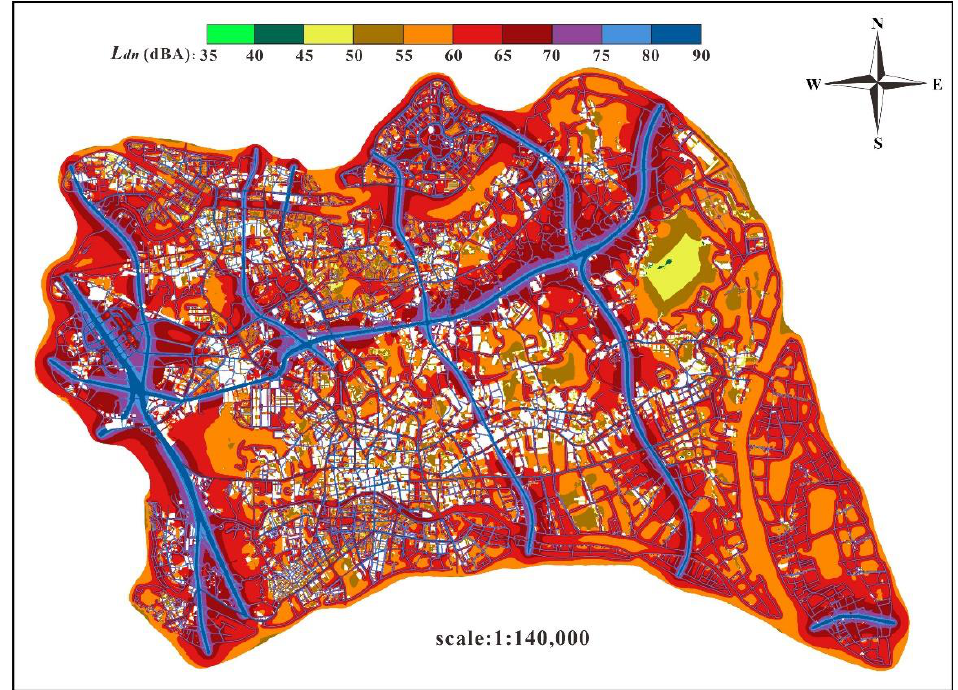
Figure 8. Day – night urban traffic noise map of Panyu District, Guangzhou City with the existence of noise barriers. L dn is the A-weighted equivalent noise level over a 24 h period.